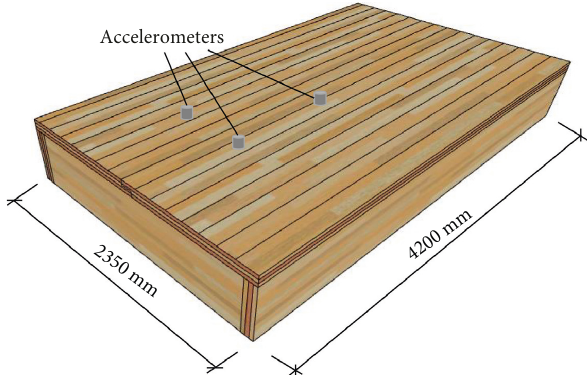
Figure 2: Schematic diagram of the floor tested.